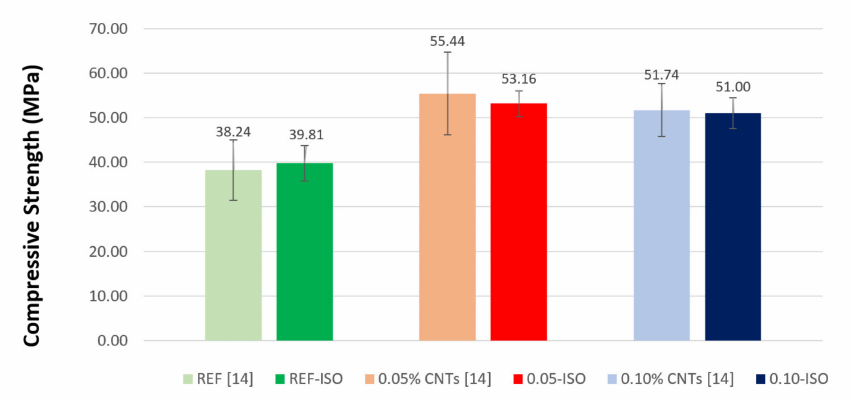
Figure 5. Compressive strength test results as compared with previous